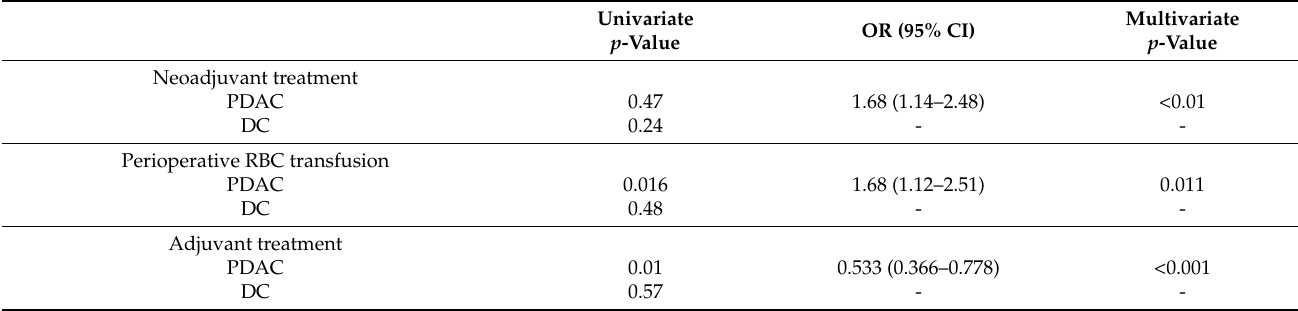
Table 3. Univariate and multivariate analyses of factors influencing the overall survival among patients with distal cholangiocarcinoma (DC) or pancreatic ductal adenocarcinoma